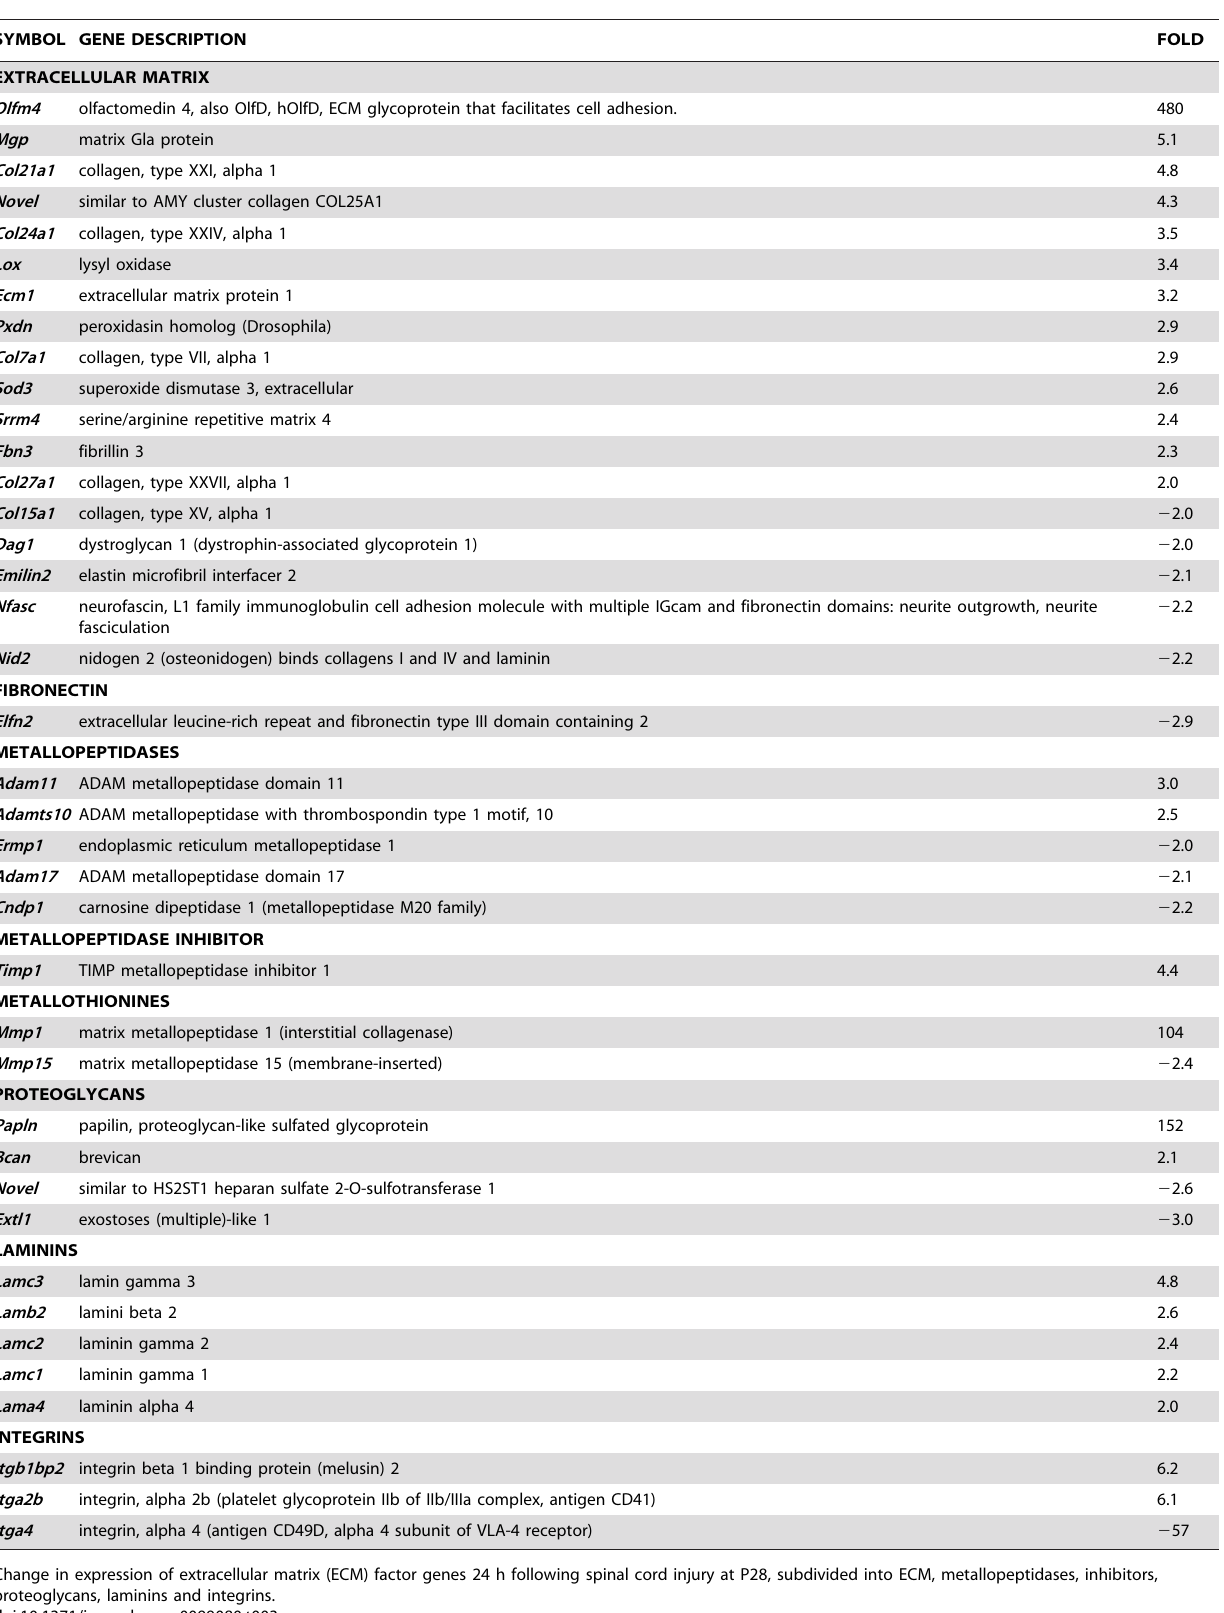
Table 3. Change in expression of extracellular matrix factor genes in 24 h following spinal cord injury at P28.